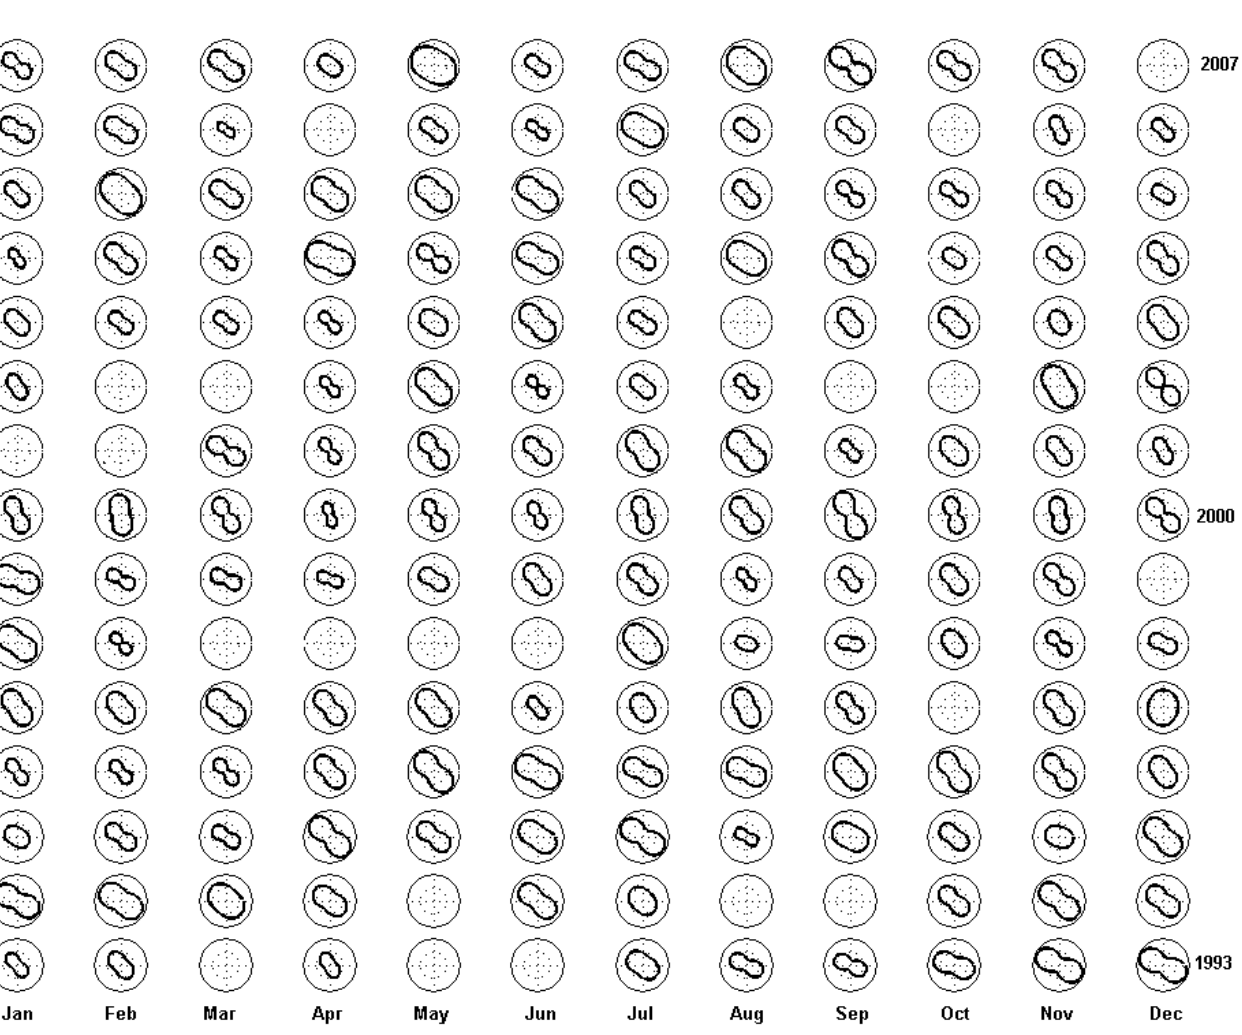
Fig. 6. Perturbation ellipses for each month of the years 1993–2007 obtained for the height region 84–94km. The radius of the outer circle is 25m 2 /s 2